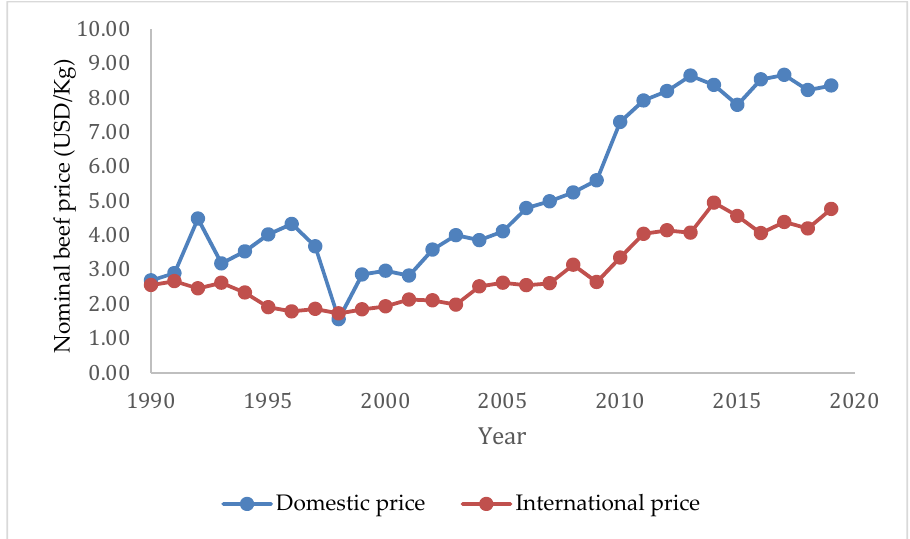
Figure 1. The trend of beef prices in the domestic and international market, 1990–2019 .